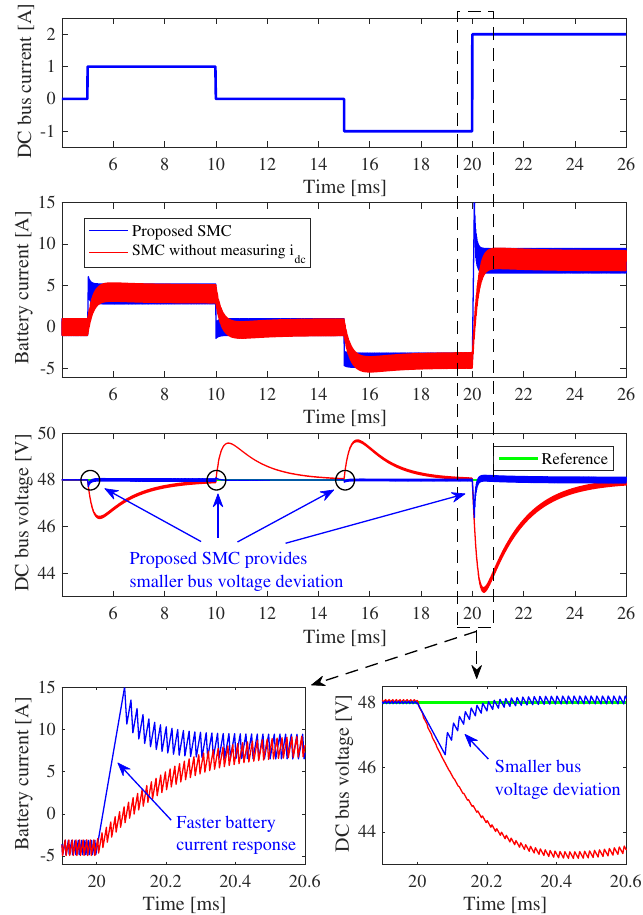
Figure 17. Simulation of both the proposed SMC and the SMC without measuring i dc presented in